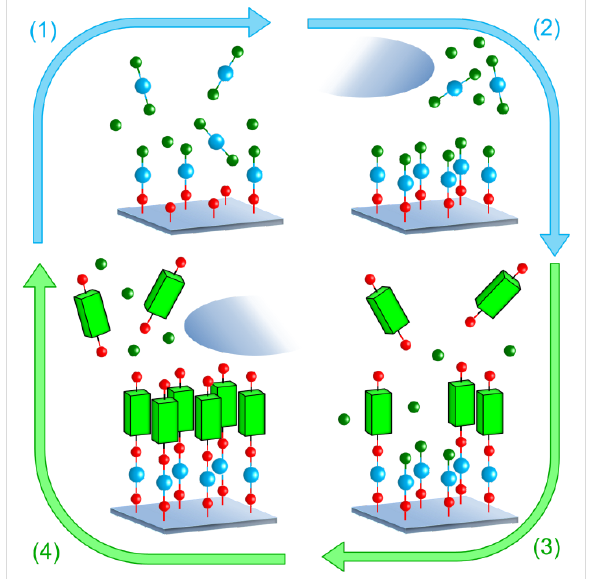
Figure 3: An ALD/MLD cycle consisting of the following four steps: (1) the first (inorganic) precursor is pulsed to the reactor and it reacts with the surface species, (2) the excess precursor and possible byproducts are removed from the reactor, either by purging with inert gas such as nitrogen or argon, or by evacuation, (3) the second (organic) precursor is pulsed to the reactor and it reacts with the surface species, and finally (4) the excess precursor/possible byprod- ucts are removed from the reactor. In an ideal case a monolayer of a hybrid inorganic–organic material is formed. To deposit thicker films this basic ALD/MLD cycle is repeated as many times as needed to reach the targeted film